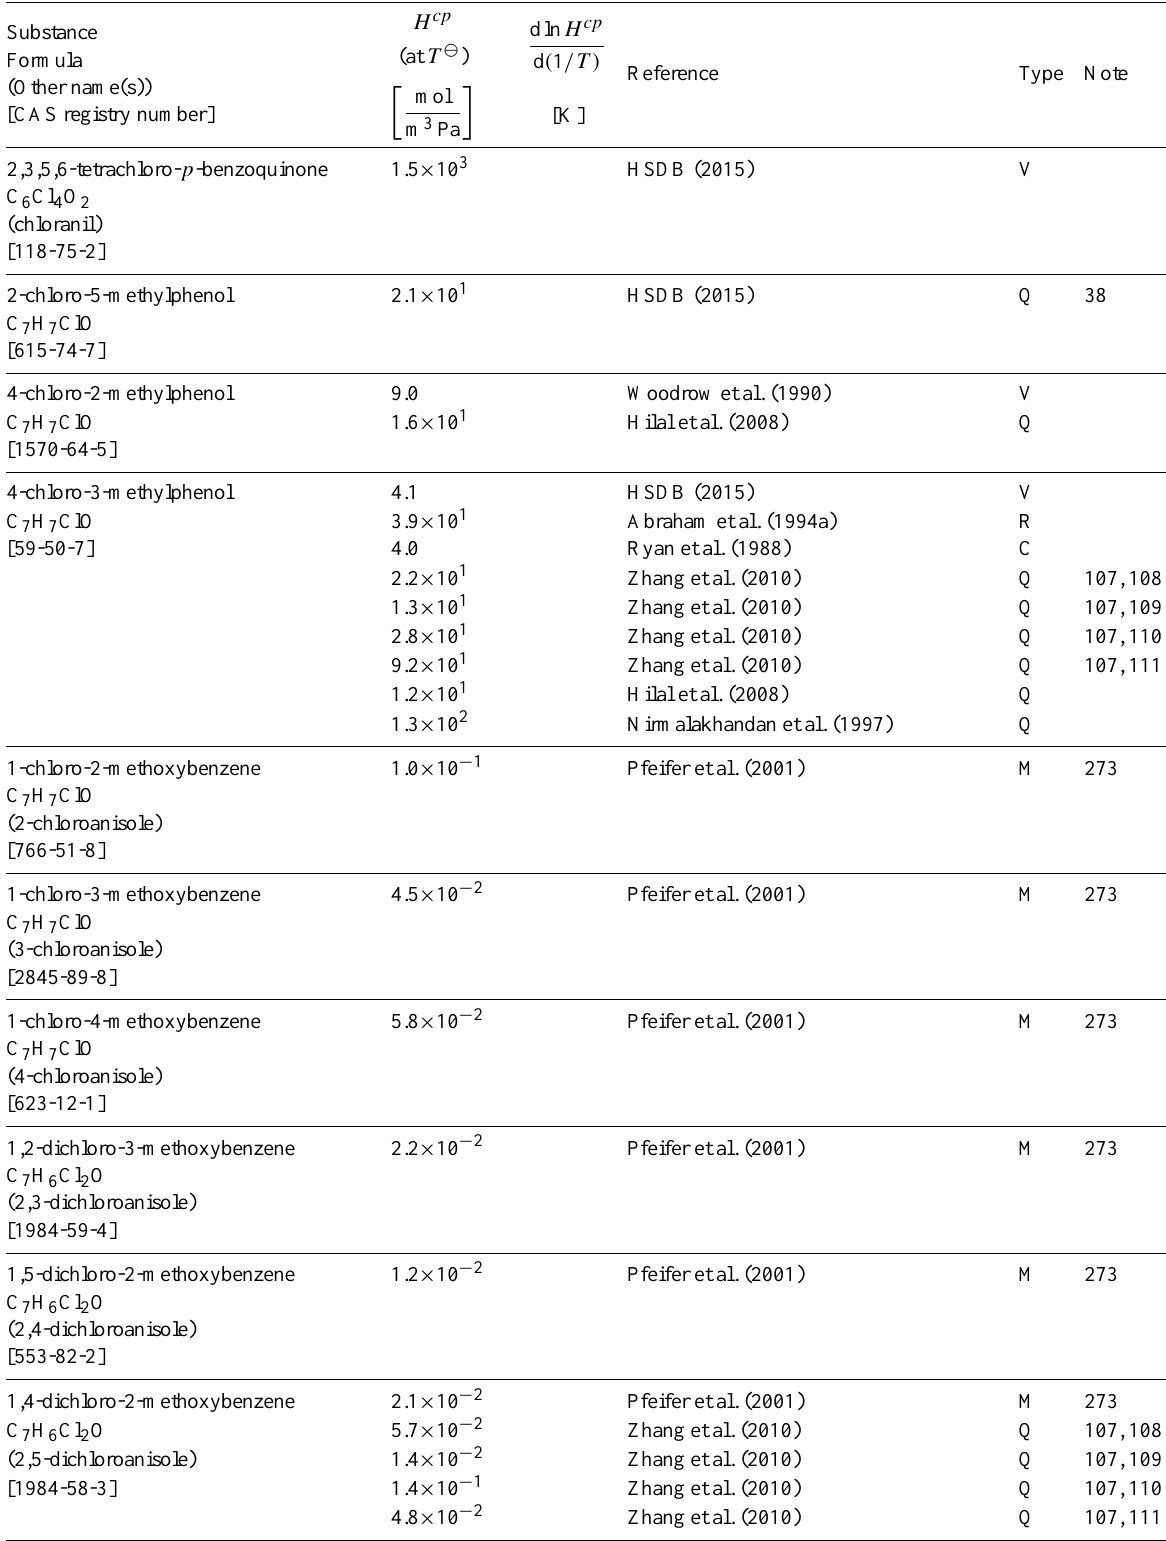
Table 6: Henry’s law constants for water as solvent